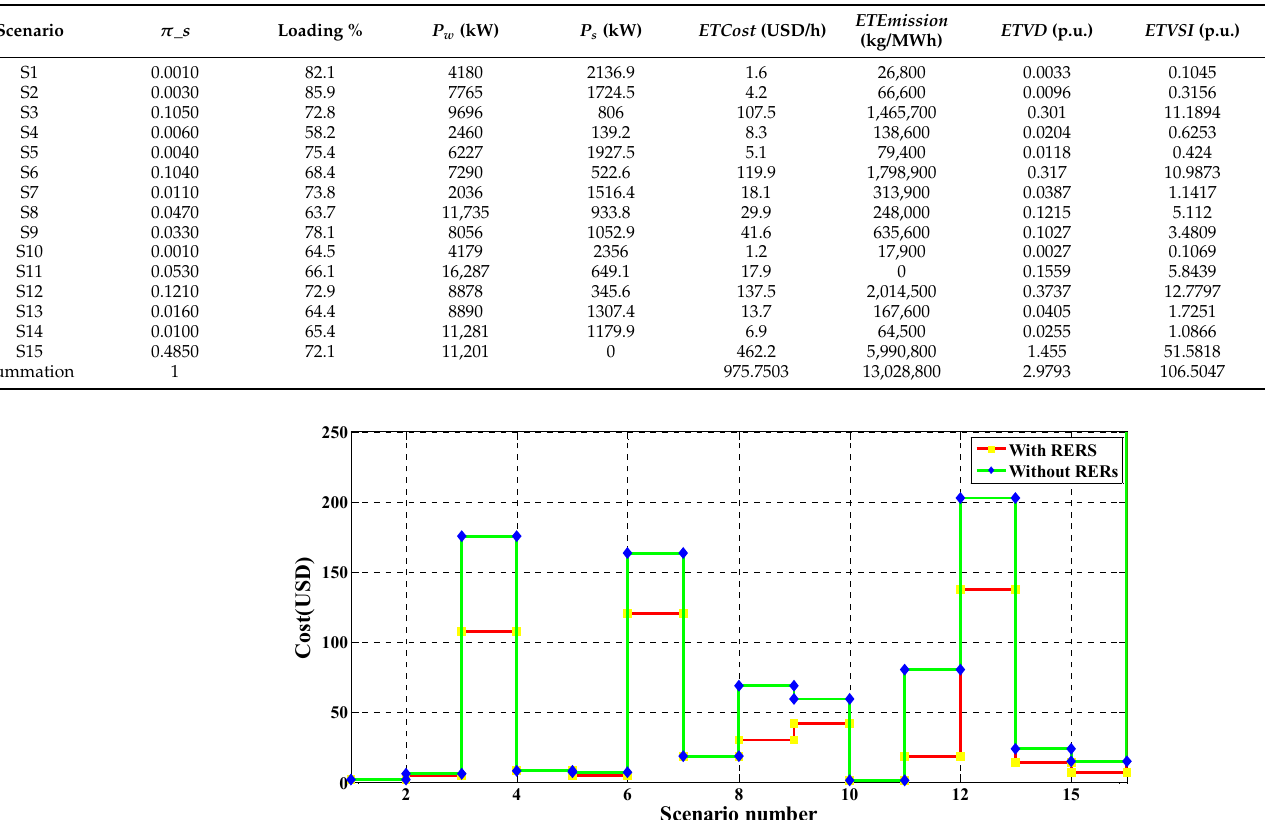
Figure 8. The IEEE 118-bus system total costs.